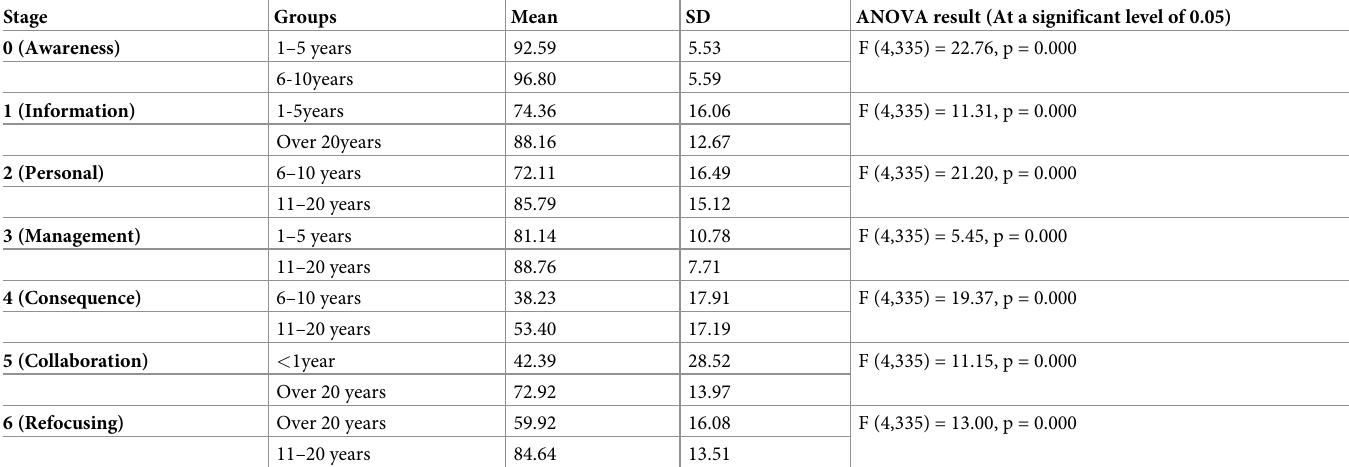
Table 5. Results of One-way ANOVA for the effect of years of teaching on the concern intensity of teachers across stages.